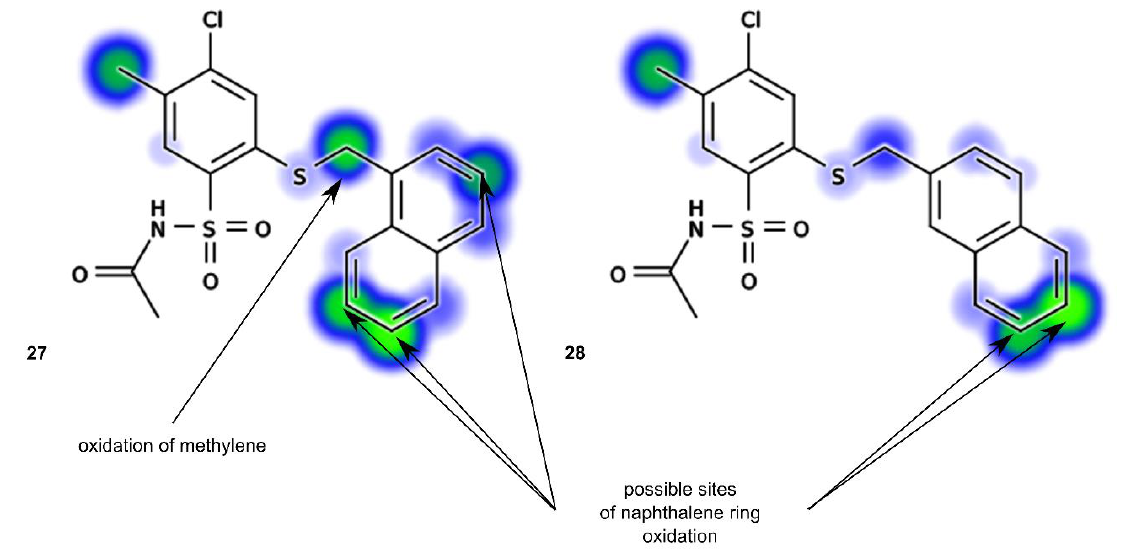
Figure 7. Sites of metabolism predicted for 27 and 28 by XenoSite software [37]. Green color indicates more vulnerability to biotransformation than blue. Some significant differences are additionally pointed